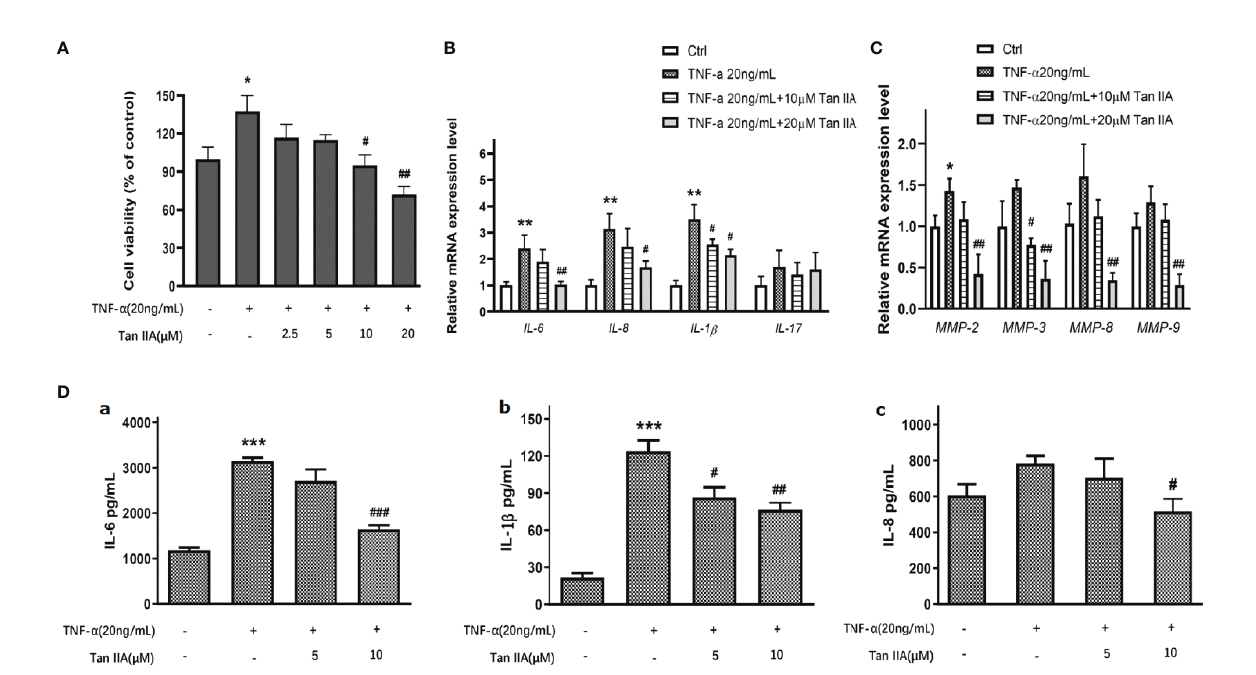
FIGURE 4 | The effect of Tan IIA on producing pro-in fl ammatory cytokines and MMPs in RA-FLSs. (A) The effect of 0, 2.5, 5, 10, and 20 m M Tan IIA on cell viability induced by TNF- a (20 ng/mL). (B) The effect of 10 m M and 20 m M Tan IIA on relative mRNA expression of pro-in fl ammatory cytokines induced by TNF- a (20 ng/mL) normalized with b -actin in RA-FLSs. (C) The effect of 10 m M and 20 m M Tan IIA on relative mRNA expression of MMP-2, MMP-3, MMP-8, and MMP-9 induced by TNF- a (20ng/mL) compared to b -actin in RA-FLSs. (D) The effect of Tan IIA on pro-in fl ammatory cytokines release induced by TNF- a in RA-FLSs. a. The effect of 10 m M and 20 m M Tan IIA on IL-6 release induced by TNF- a (20ng/mL). b. The effect of 10 m M and 20 m M Tan IIA on IL-1 b release induced by TNF- a (20ng/mL). c. The effect of 10 m M and 20 m M Tan IIA on IL-8 release induced by TNF- a (20ng/mL). The values are the mean ± SEM from at least 3 independent experiments. * P < 0.05, ** P < 0.01, *** P < 0.001 vs. Ctrl (0 m M Tan IIA and 0 ng/mL TNF- a ). # P < 0.05, ## P < 0.01, ### P < 0.001 vs. group treated with TNF- a (20